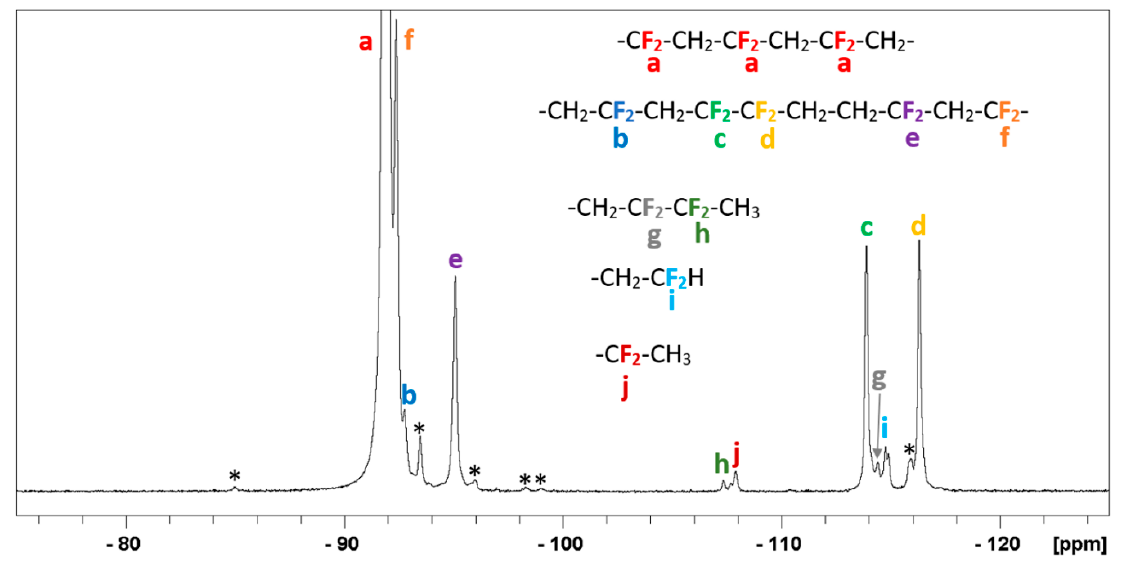
Figure 4. 19 F NMR spectrum (376.5 MHz, DMF- d 7 ) between − 75 and − 125 ppm of the PVDF obtained